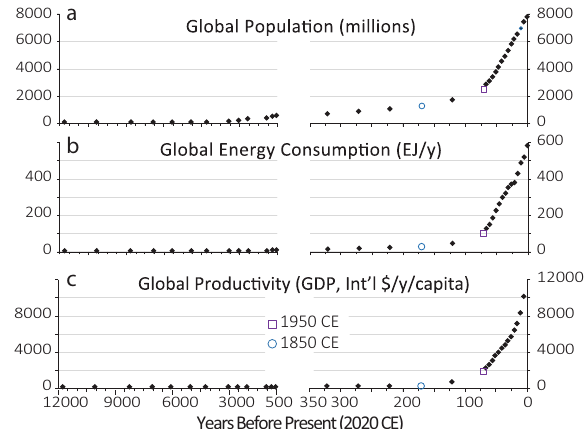
Fig. 1 Correlation of global human population, energy consumption and productivity during the Holocene and Anthropocene epochs. a Global human population (millions), b global energy consumption (EJ/y), and c global productivity ($/y/capita), across the Holocene and proposed Anthropocene epochs (in this paper starting in 1950 CE). All three parameters are highly correlated (Spearman ’ s rank coef fi cient = 1.00). Larger circle = 1850 CE; large square = 1950 CE. Data references are listed in Supplementary Online